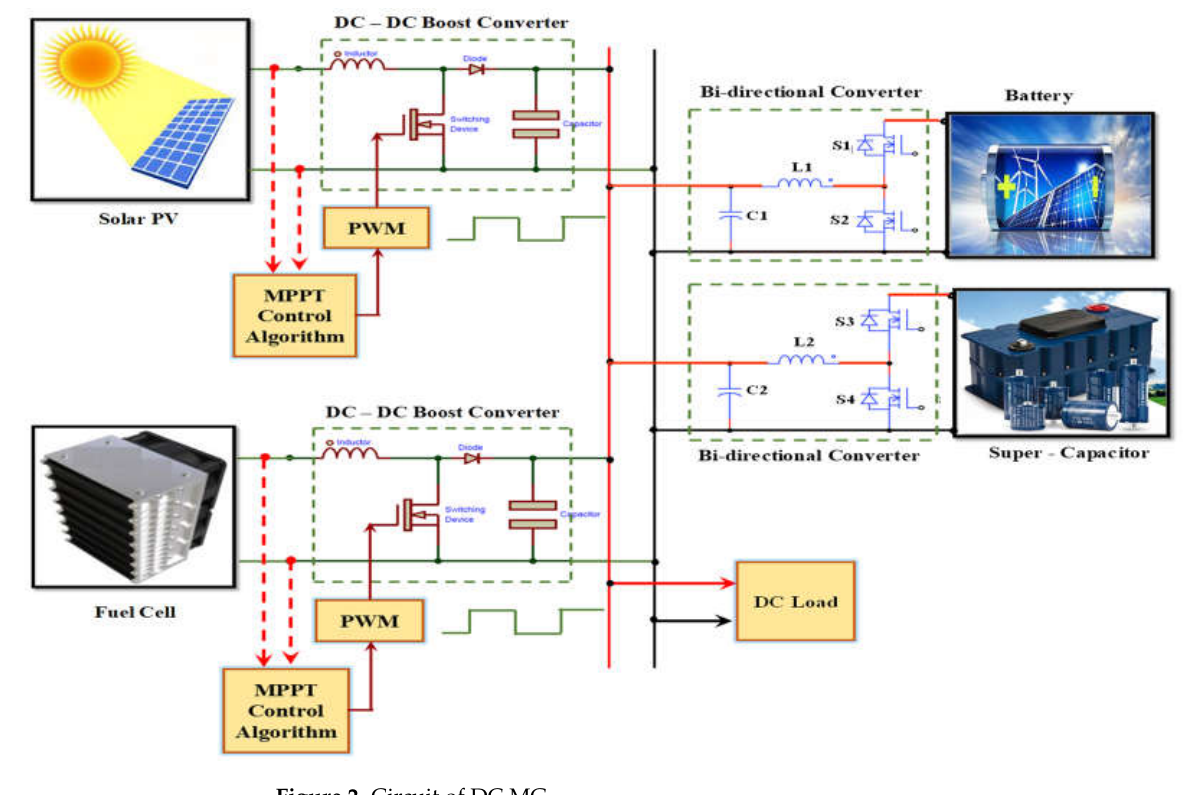
Figure 2. Circuit of DC MG.